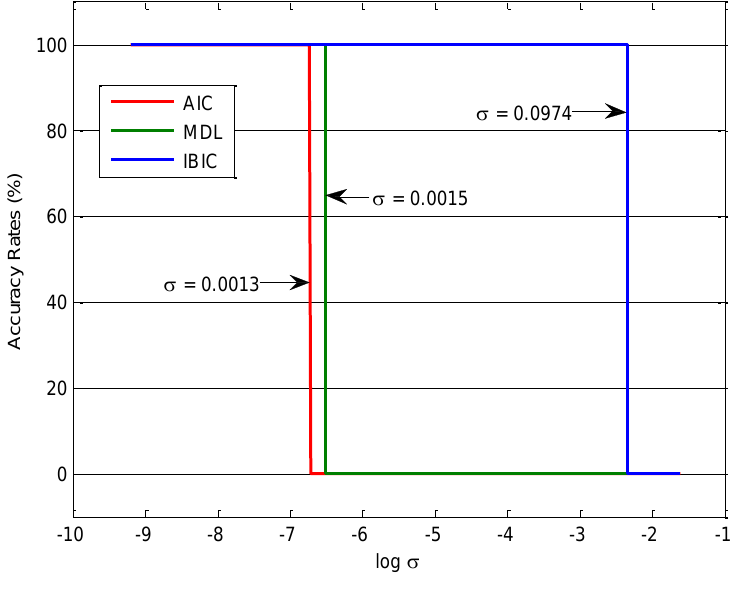
Figure 5. The waveforms of the mixed signals for 0.0974 